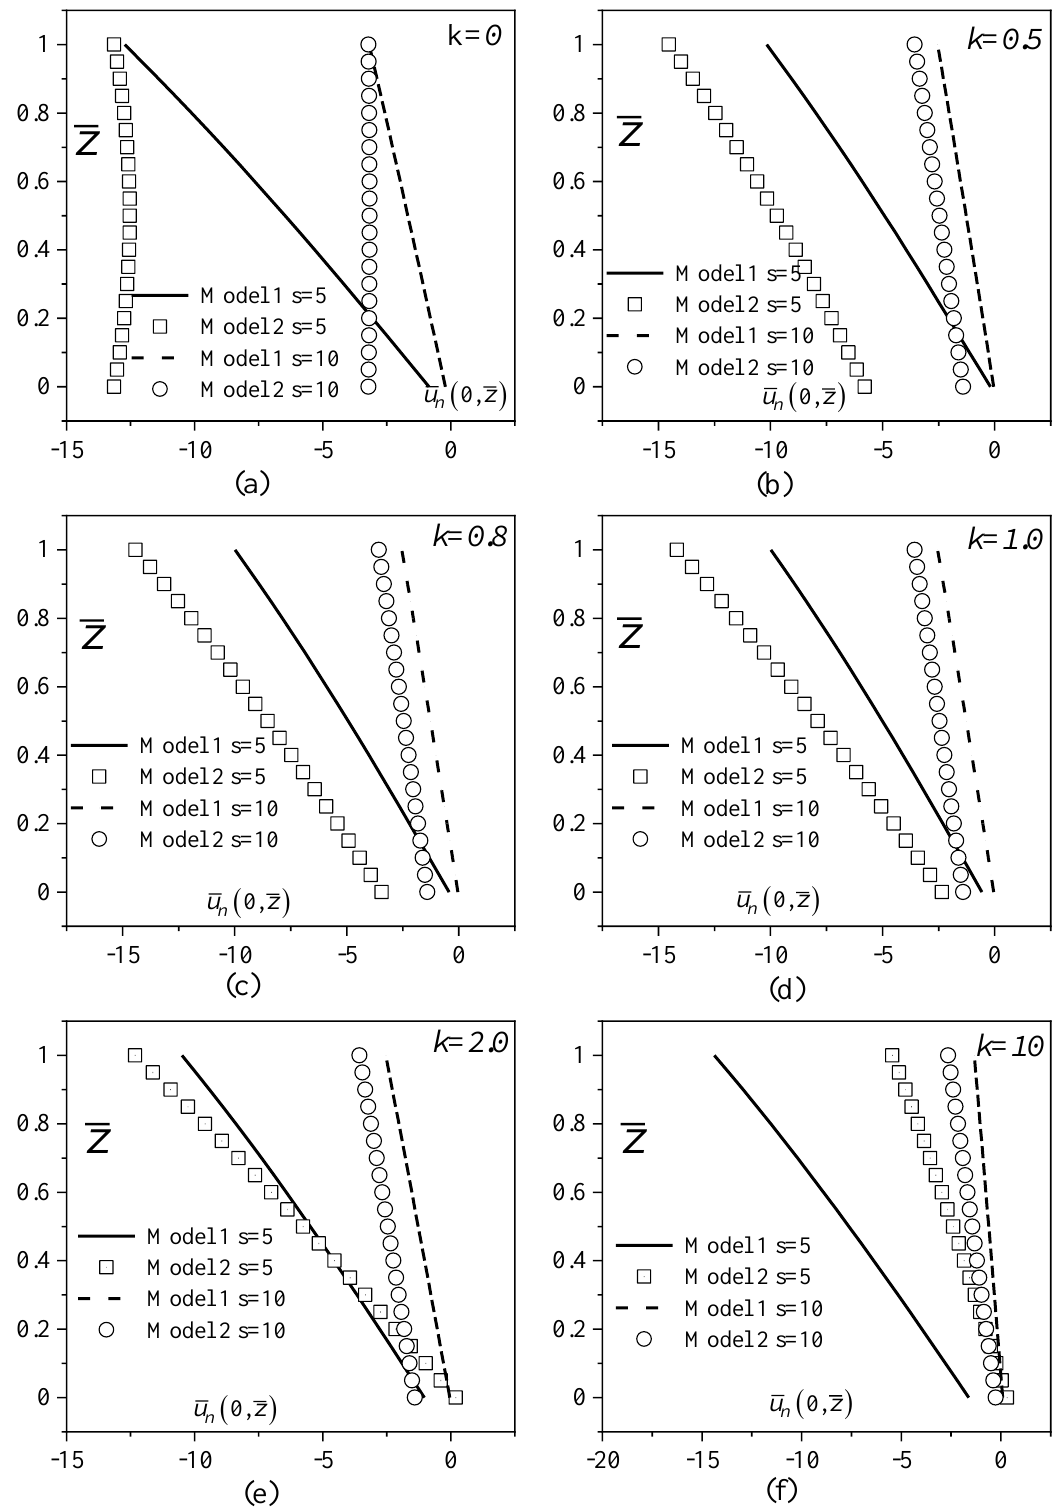
u ) for various graded FG laminate n [Material set